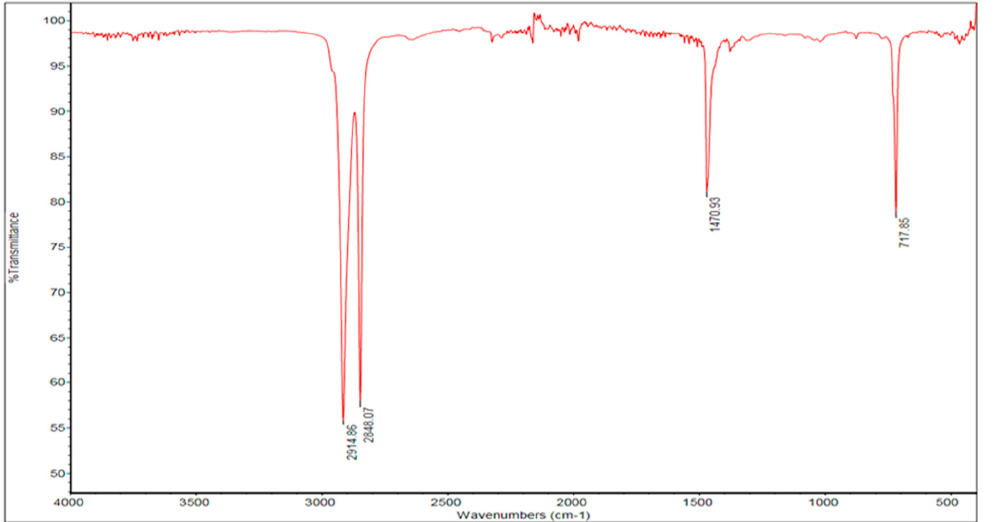
Figure 11. FTIR analysis of LLDPE after the addition of 1% weight of pro-oxidant additive at day